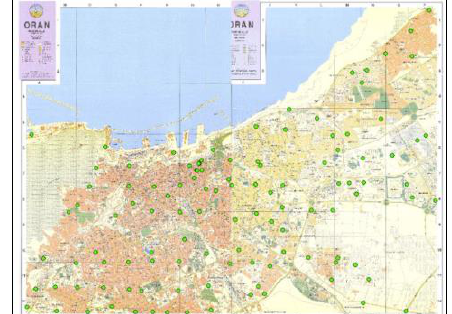
Figure 5. Distribution of the 118 reference points (green dot) in the